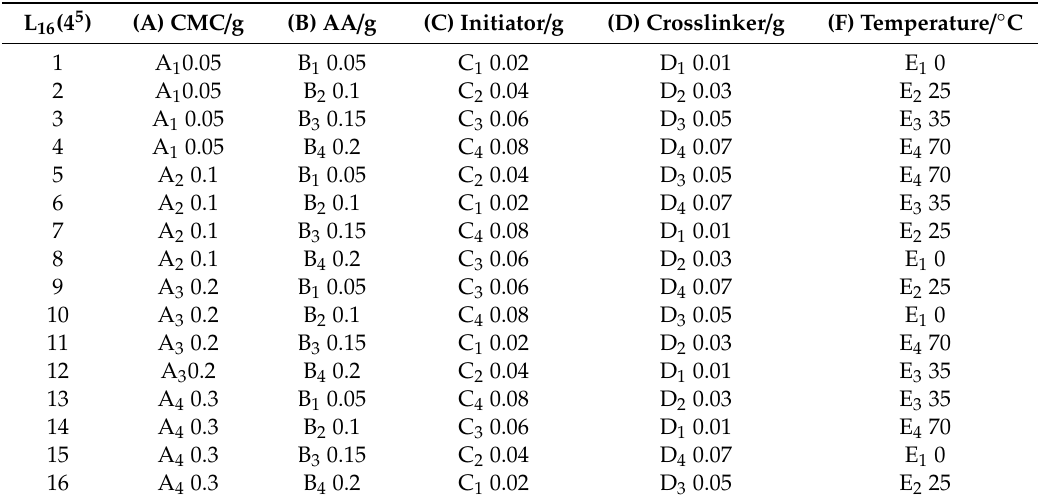
Table 3. Arrangements of the 5-variable 4-level orthogonal